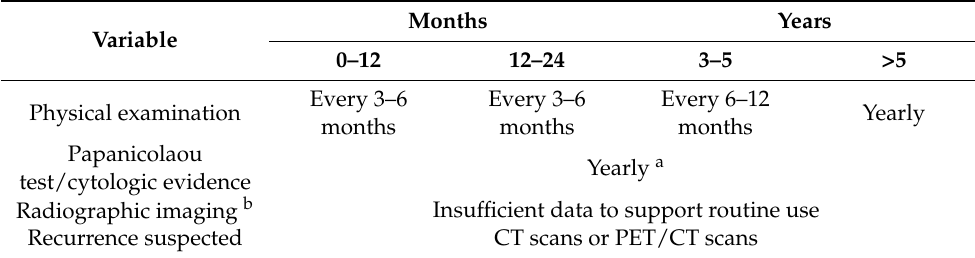
Table 4. Vulvar cancer surveillance recommendations